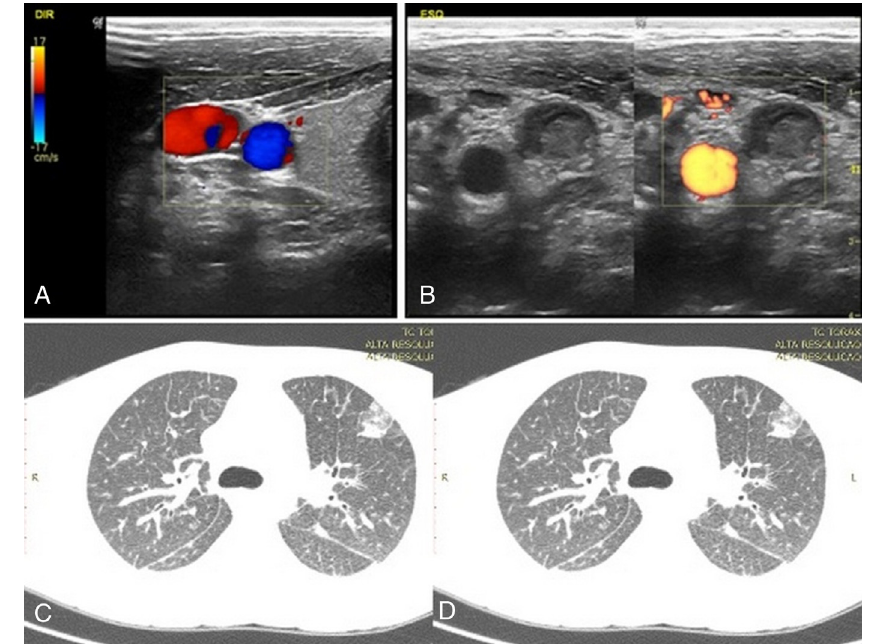
Figure 1 (A) Right cervical doppler ultrasound scan with normal vascular flow. (B) Flow absent in left internal jugular vein. (C) Computed tomography of chest; lung parenchyma showing multiple nodes. (D) Ground-glass appearance in lung bases.